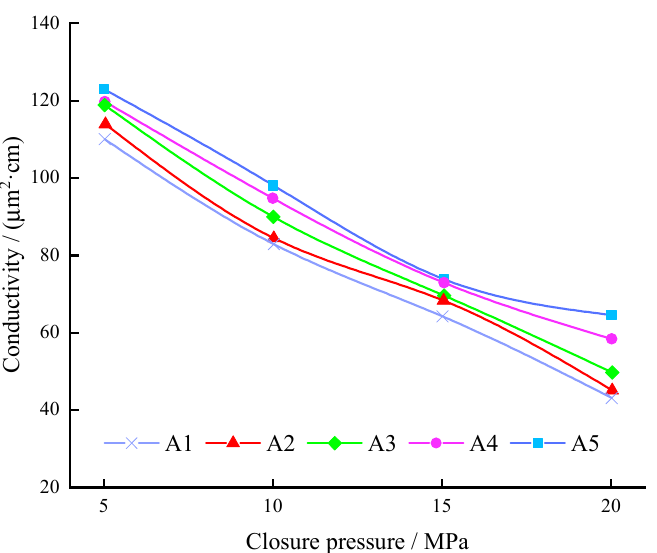
Figure 8. Effect of fiber addition on conductivity under different closing pressure conditions..